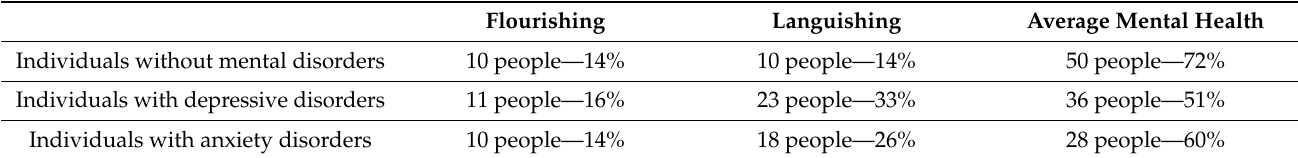
Table 4. Participants who were flourishing, languishing, and with average mental health in the three groups. Flourishing Languishing Average Mental Health Individuals without mental disorders 10 people—14% Individuals with depressive disorders